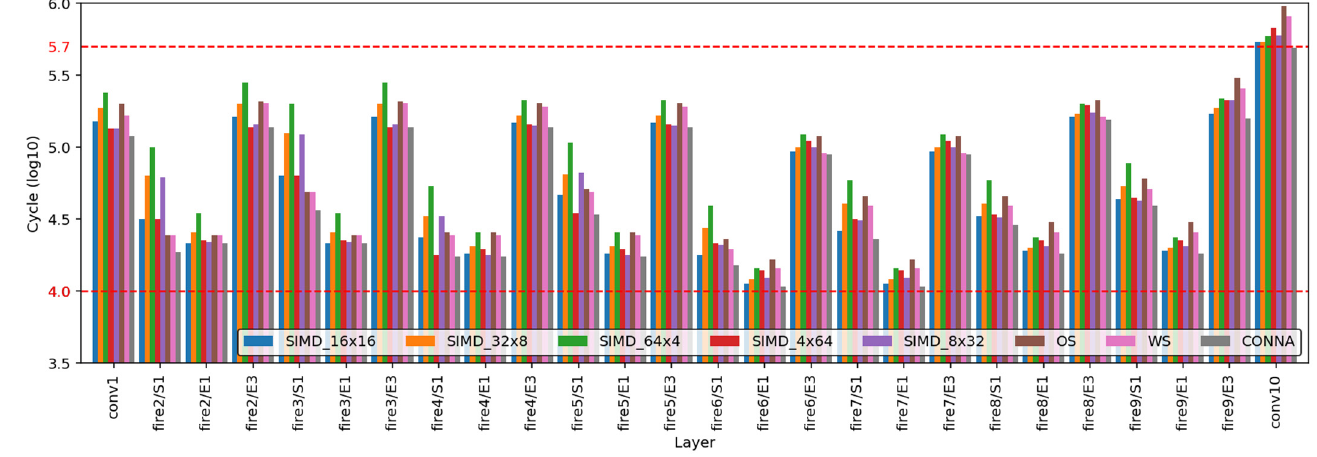
Figure 16. Computation cycles of SIMD, OS SA, WS SA, and CONNA on SqueezeNet